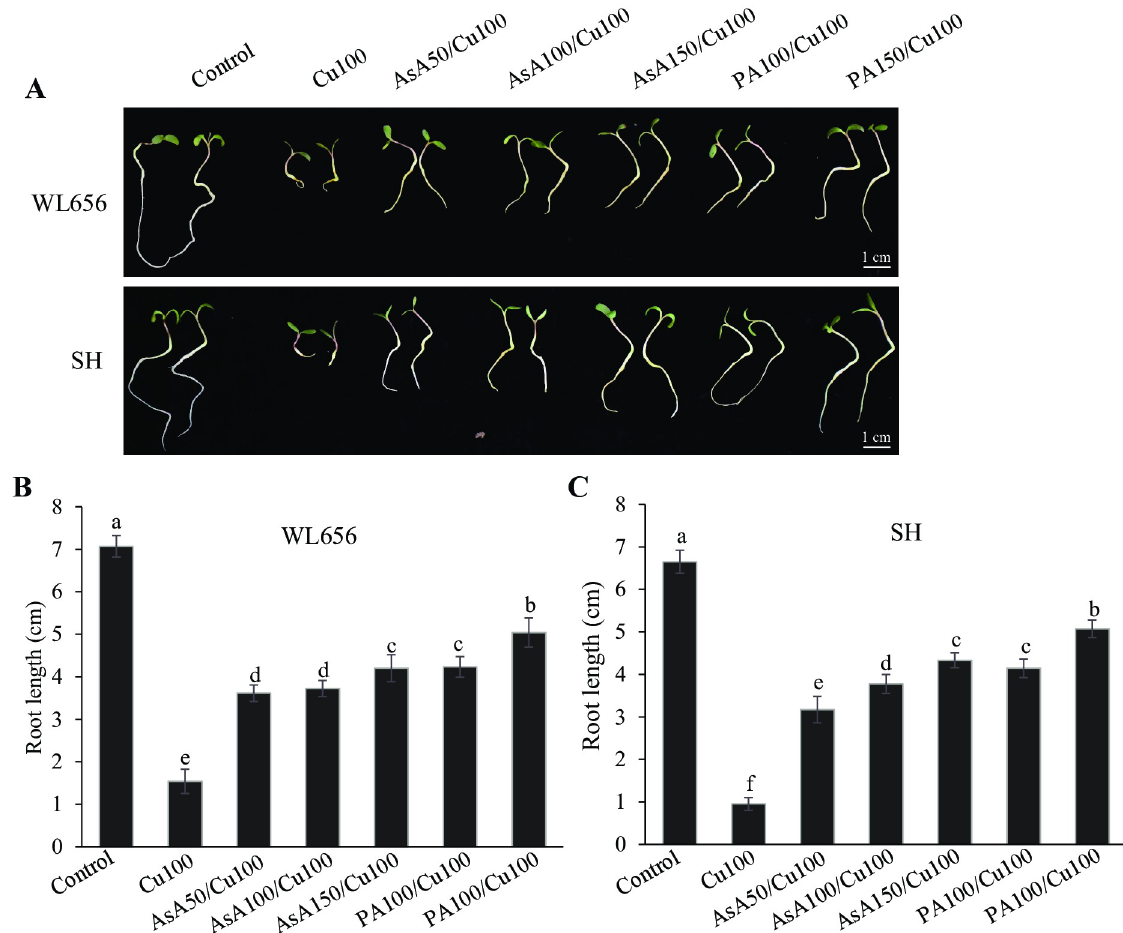
Fig 3. Ascorbic acid (AsA) improved alfalfa seedling growth under excess Cu conditions. (A) The phenotype of seedlings after 8 d of excess Cu treatment or pretreated with different concentrations of AsA. AsA increased the root length of WL656 (B) and SH (C) under Cu stress. Cu100: 100 mg L -1 CuSO 4 •5H 2 O, AsA50: 50 mg L -1 AsA pretreatment, AsA100: 100 mg L -1 AsA pretreatment, AsA150: 150 mg L -1 AsA pretreatment, PA100: 100 mg L -1 PAs pretreatment, PA150: 150 mg L -1 PAs pretreatment. Means ± SE of three biological replicates. Significant differences ( p � 0.05) are denoted by different lowercase